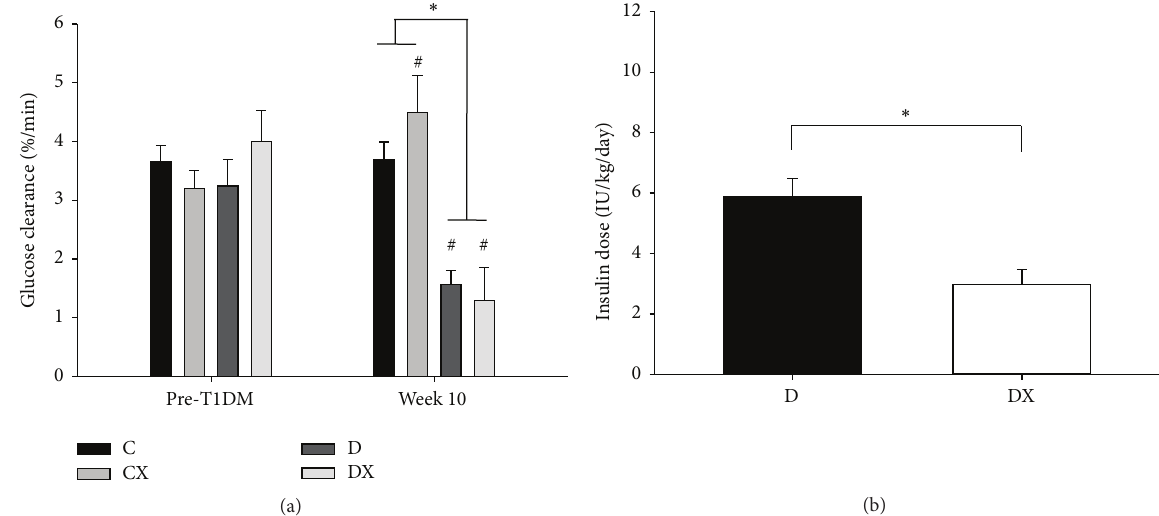
Figure 2: (a) IVGTT glucose clearance rate ( 𝐾 G ) values prior to T1DM induction (pre-T1DM) and week 10 of exercise training: C, sedentary control ( 𝑛 = 16 ); CX, control exercise ( 𝑛 = 15 ); D, sedentary T1DM ( 𝑛 = 15 ); DX, T1DM exercise ( 𝑛 = 15 ). (b) Insulin dosages at week 10: D ( 𝑛 = 16 ); DX ( 𝑛 = 16 ). ∗ Significantly different groups ( 𝑝 < 0.05 ). # Significantly different from week 1. Data are mean ±